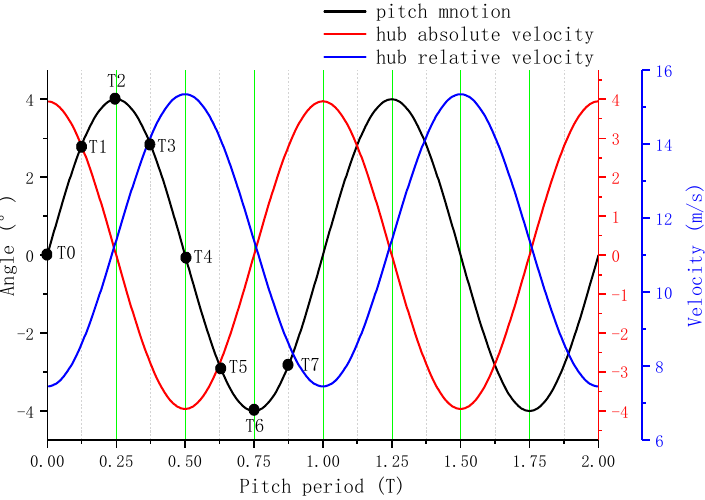
Figure 4. Pitch motion analysis under case 3 ( 𝐴 (cid:3017) = 4 ° , 𝑓 (cid:3017) = 0.1 Hz ).